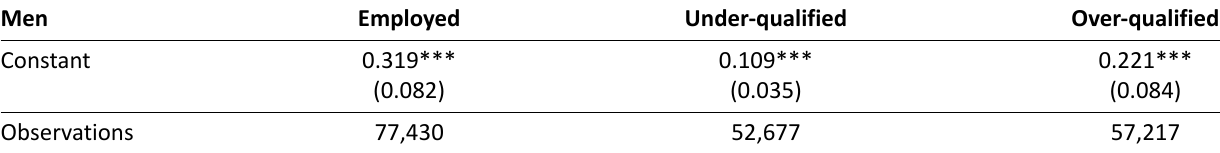
Table A3. (Cont.) Binary logistic regression model (odds ratio) of employment, under- and over-qualification for men. Men